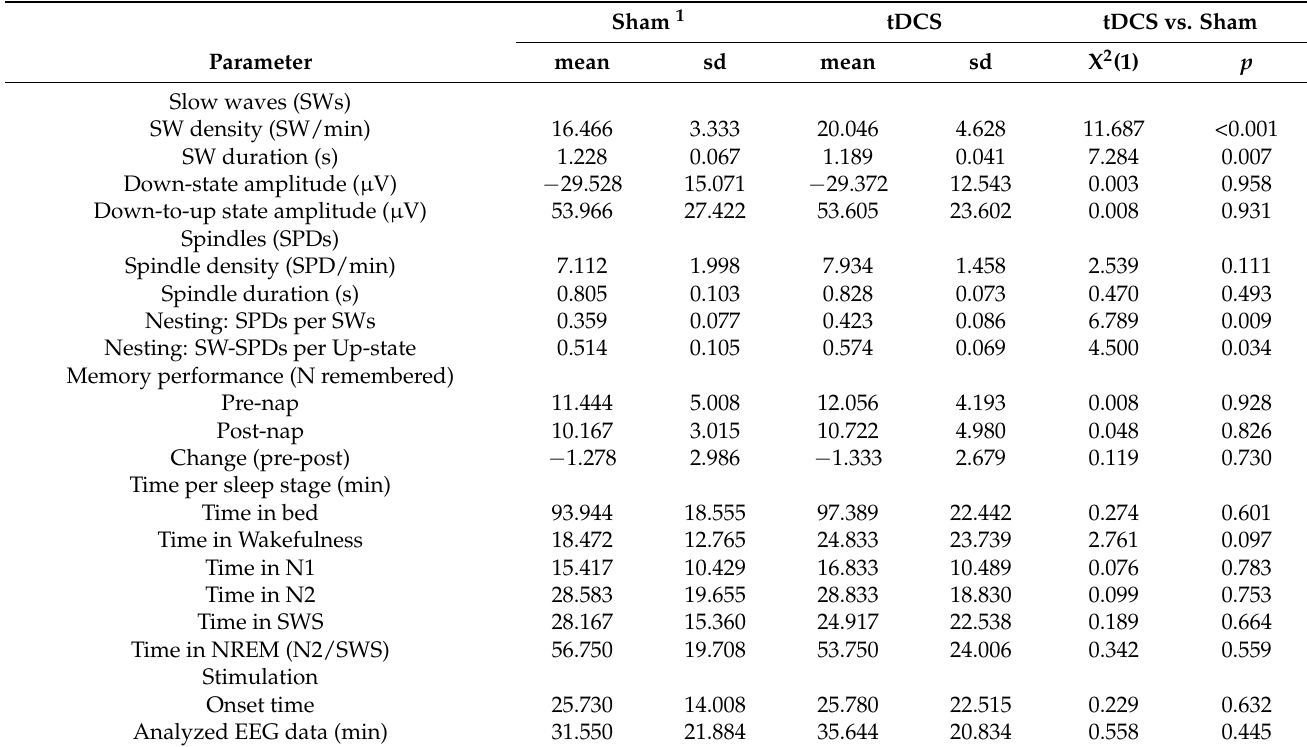
Table 1. No statistically significant differences between sham tDCS and active tDCS were found for any sleep macrostructure parameters. Table 1. Descriptive statistics for all relevant parameters for the sham vs. the tDCS